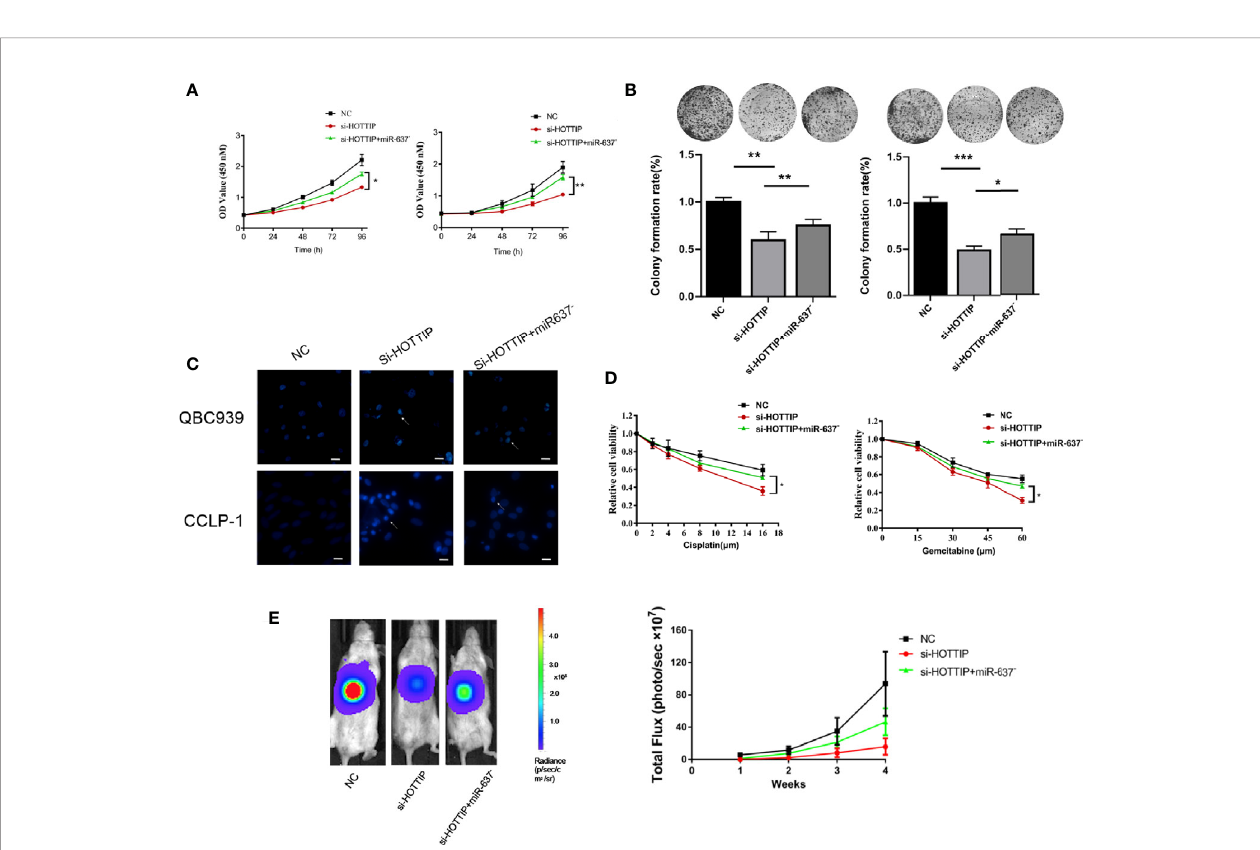
FIGURE 4 | miR-637 inhibition dismissed the chemosensitivity enhancement induced by HOTTIP inhibition. The proliferation (A) and cell colony formation (B) of QBC939 and CCLP-1 cells. The si-NC, si-HOTTIP, and si-HOTTIP+ miR-637 inhibitor-transfected cells were pretreated with CG for 24 h before normal incubation. (C) Hoechst staining was used for apoptosis detection. (D) CG dose-dependent analysis of the three kinds of cells. (E) Bioluminescent imaging of the subcutaneous QBC939 tumor model. (*p < 0.05, **p < 0.01, ***p < 0.001).